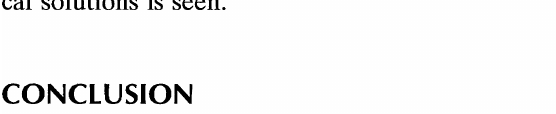
FIGURE 10 Nondimensional radial velocity vs. nondimensional time for the infinite cylinder/plane step wave